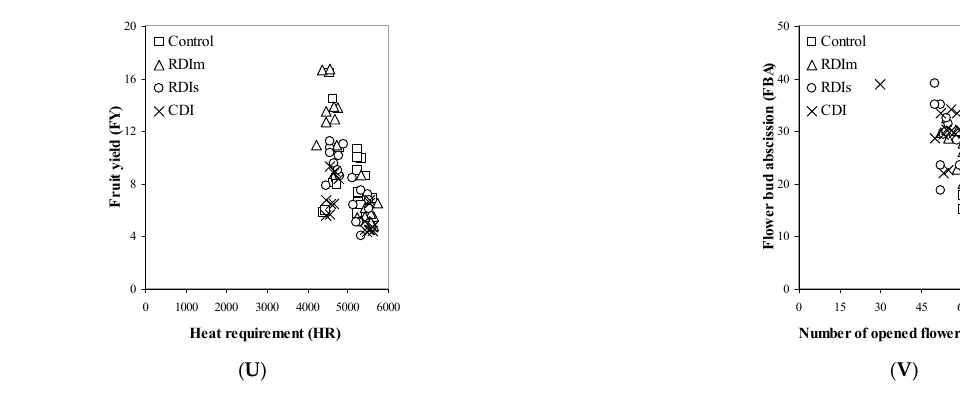
Figure 9. Relationships between 22 significant variable-pairs (TNB versus (vs.) NFB ( A ), TNB vs. NOFB ( B ), NFB vs. NOFB ( C ), NFB vs. FNT ( D ), NFB vs. FY ( E ), NFB vs. FW ( F ), NOFB vs. SVG ( G ), NOFB vs. FNT ( H ), NOFB vs. FY ( I ), FS vs. FNT ( J ), FS vs. FY ( K ), SVG vs. FNT ( L ), SVG vs. FY ( M ), SVG vs. TSC ( N ), FNT vs. FY ( O ), FY vs. FW ( P ), CR vs. TSC ( Q ), HR vs. TNB ( R ), HR vs. NFB ( S ), HR vs. FNT ( T ), HR vs. FY ( U ), and NOFB vs. FBA ( V )) for four deficit irrigation treatments Agronomy 2021 , 11 , 1361 (Control, RDIm, RDIs, and CDI). Explanations for Control, RDIm, RDIs, and CDI are given in Figure 2.